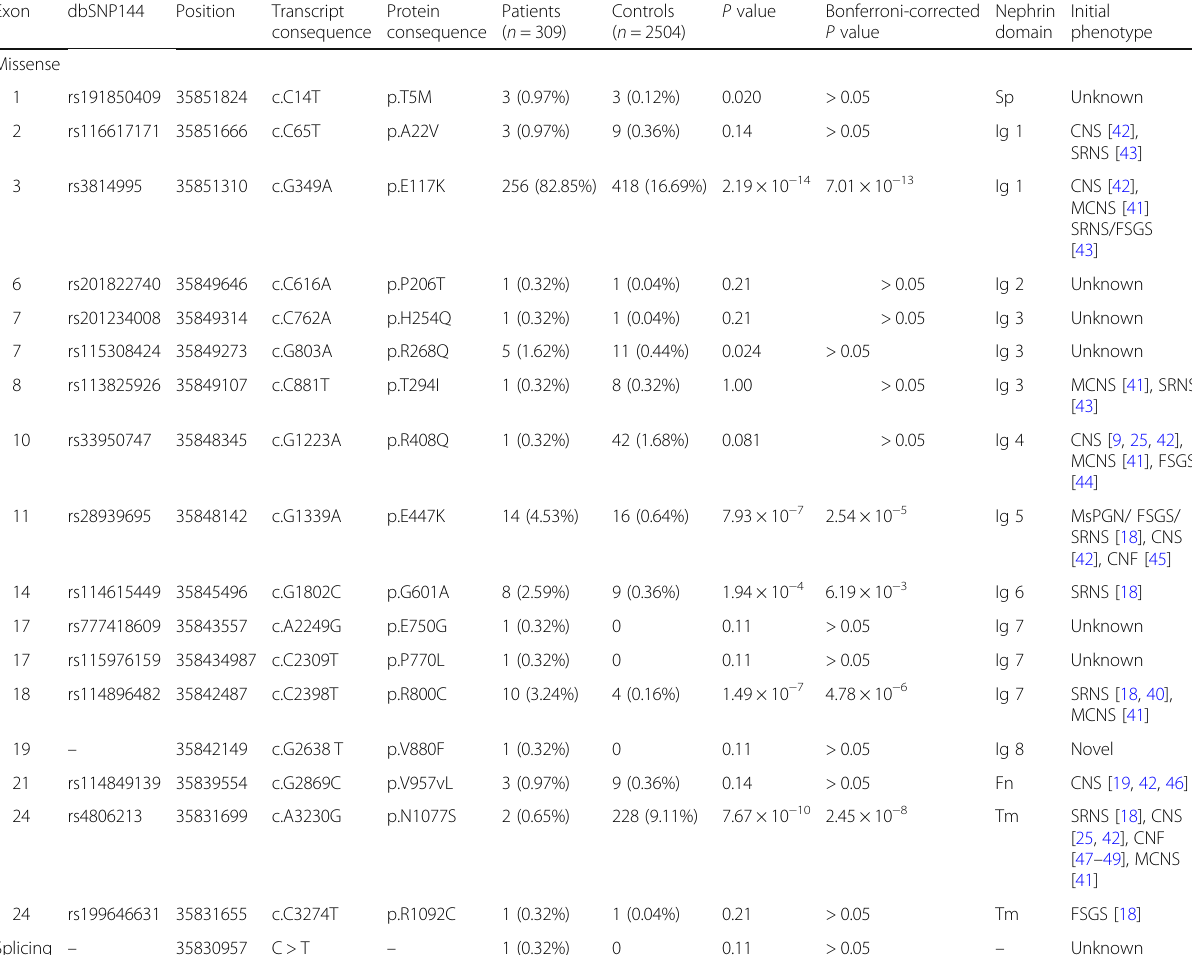
Table 2 The missense and splicing mutations detected in FSGS patients and compared with controls from 1000 Genomes Project Exon dbSNP144 Position Transcript